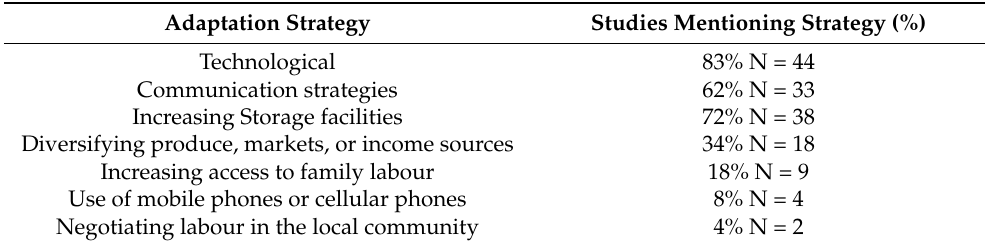
Table 3. Adaptations mentioned and the percentages of articles in which they are found. Adaptation Strategy Studies Mentioning Strategy (%) Technological 83% N = 44 Communication strategies 62% N = 33 Increasing Storage facilities 72% N = 38 Diversifying produce, markets, or income sources 34% N =